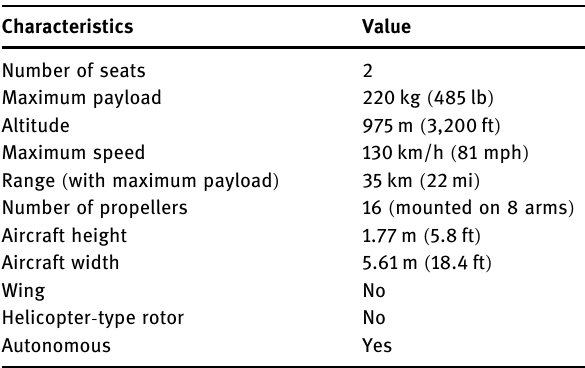
Table 1: Some Characteristics of EHang 216 UAM Aircraft